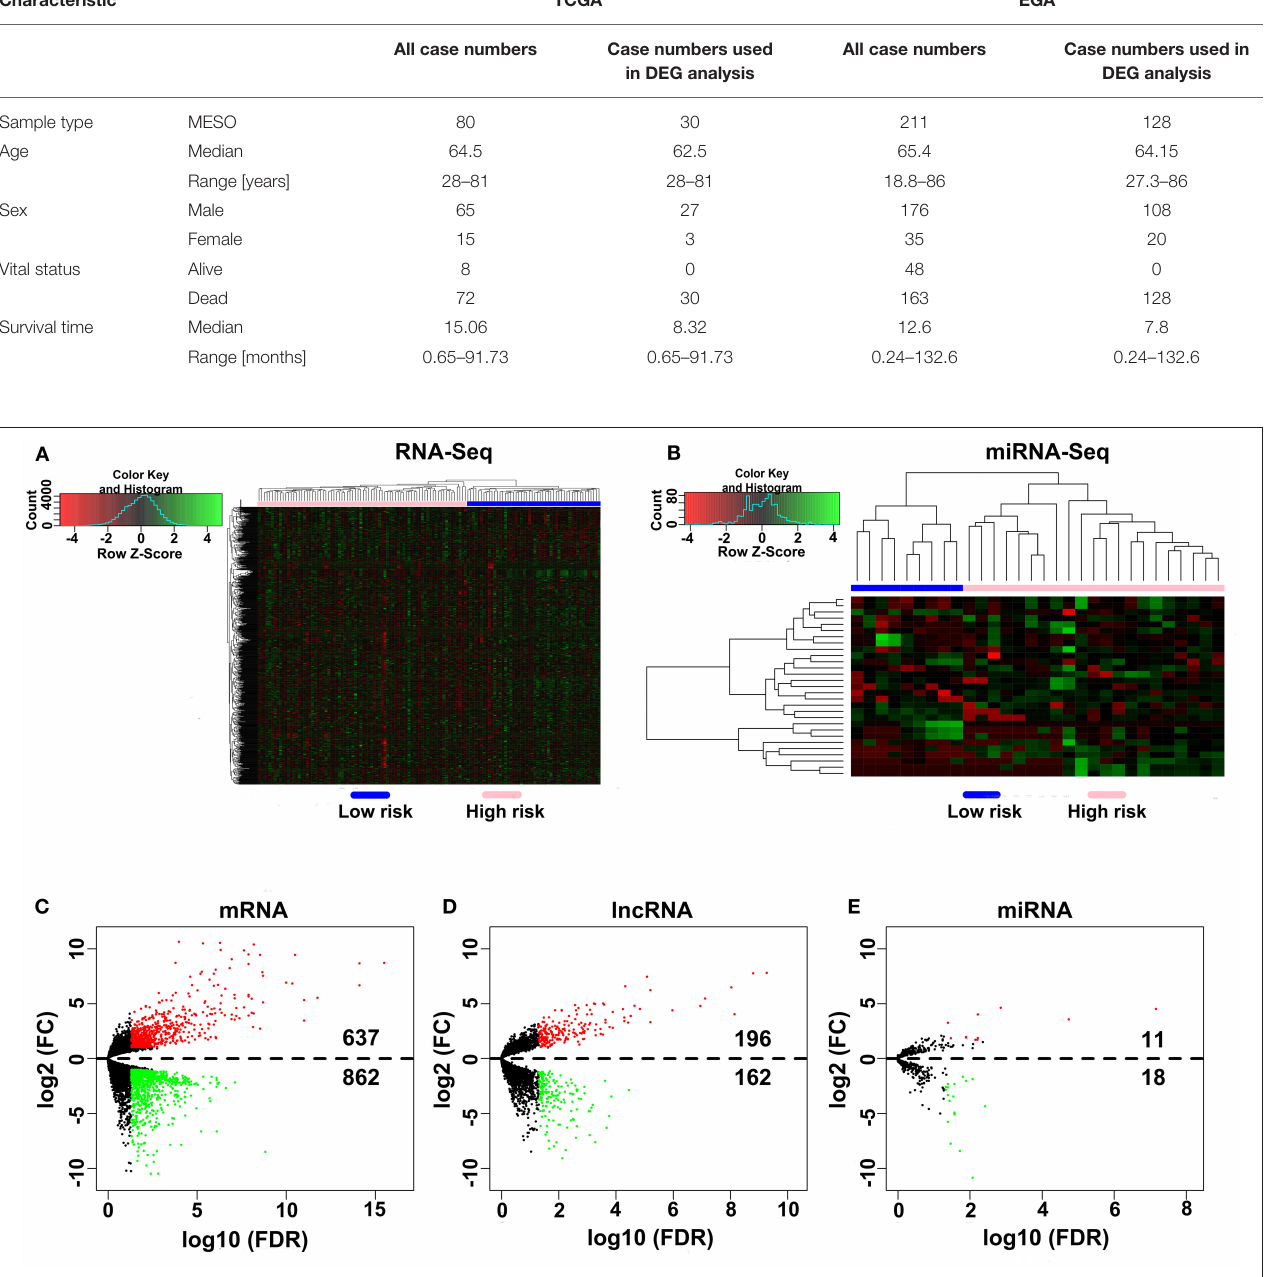
FIGURE 1 | Differential expression gene analyses. (A,B) DEG heatmap of the RNA-Seq and the miRNA-Seq. (C–E) Screening of the DEmRNA, DElncRNA, and DEmiRNA. Black points represent the insignificant genes, red points represent the upregulated genes, and green points represent the downregulated genes. FC, fold change. Threshold criteria: FC > 2 and FDR <